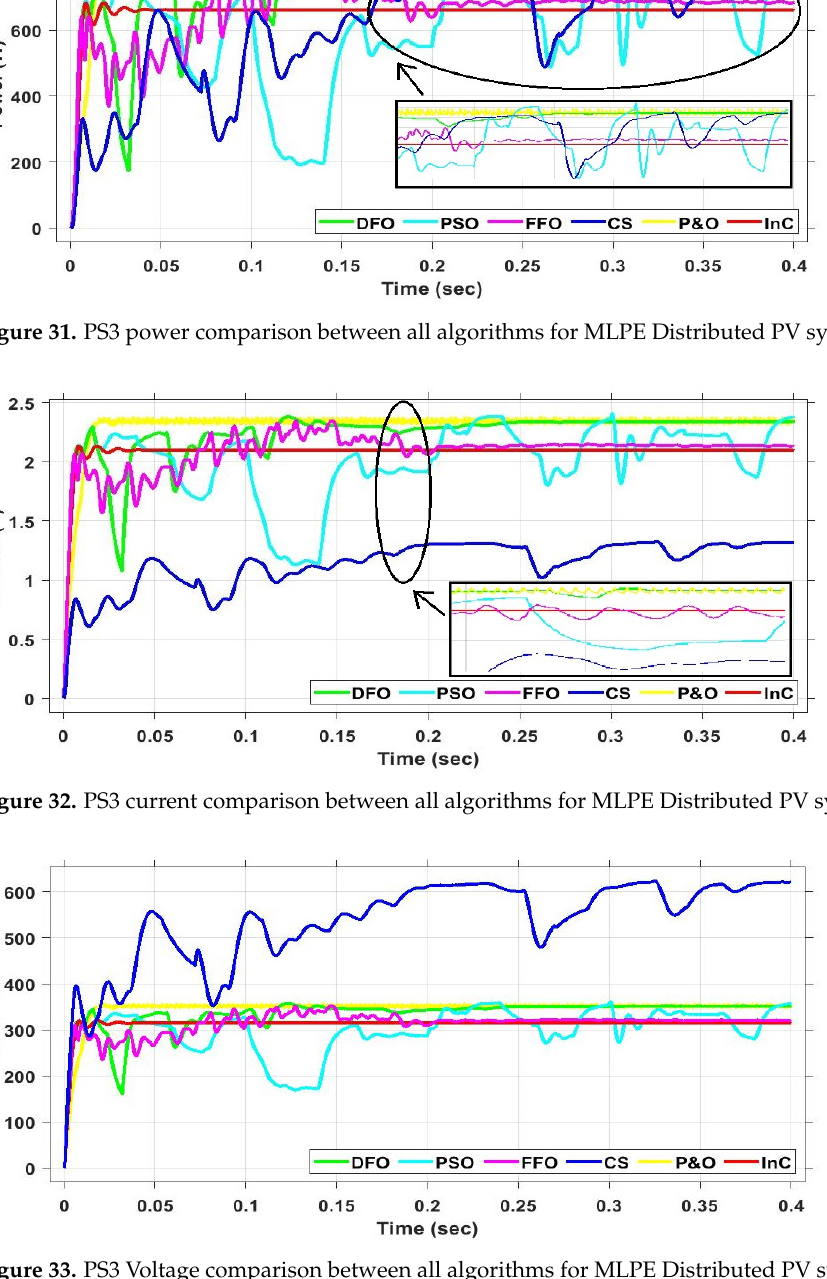
Figure 33. PS3 Voltage comparison between all algorithms for MLPE Distributed PV